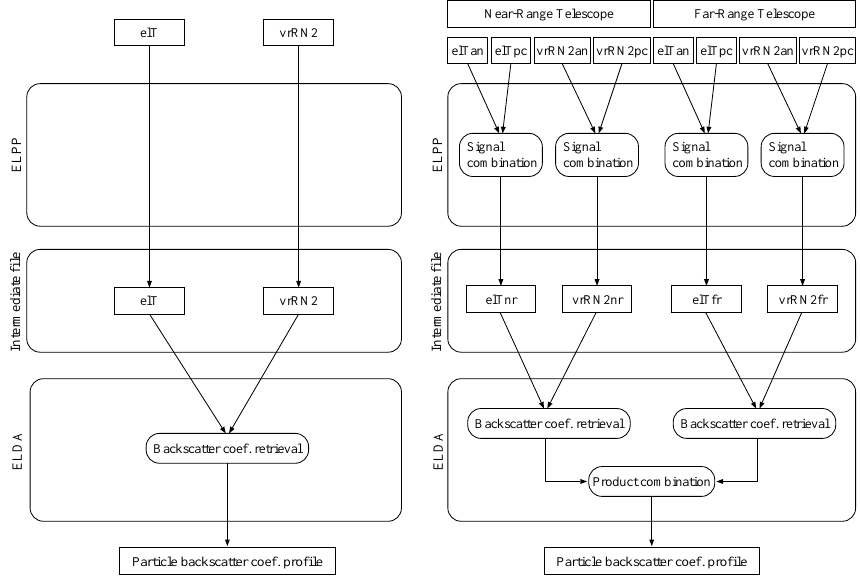
Figure 3. Two examples of SCC usecases corresponding to the calculation of particle backscatter coefficient determined by the use of Raman signals. In particular, the usecase 0 (on the left) can be used for a lidar system measuring only the elastic backscattered signal (elT) and the corresponding N 2 Raman backscattered signal (vrRN2). The usecase 13 (on the right) refers to a more complex lidar configuration in which there are two different telescopes. Four lidar channels are detected by each telescope: one elastic backscattered signal split in analog (elTan) and photon-counting (elTpc) detection channels and one N 2 Raman backscattered signal split in analog (vrRN2an) and photon-counting (vrRN2pc) detection